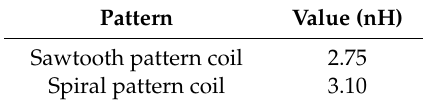
Figure 4. Configuration comparison: ( a ) Sawtooth pattern coil; ( b ) spiral pattern coil. Table 1. Mutual inductance with respect to the pattern of the pick-up coil.